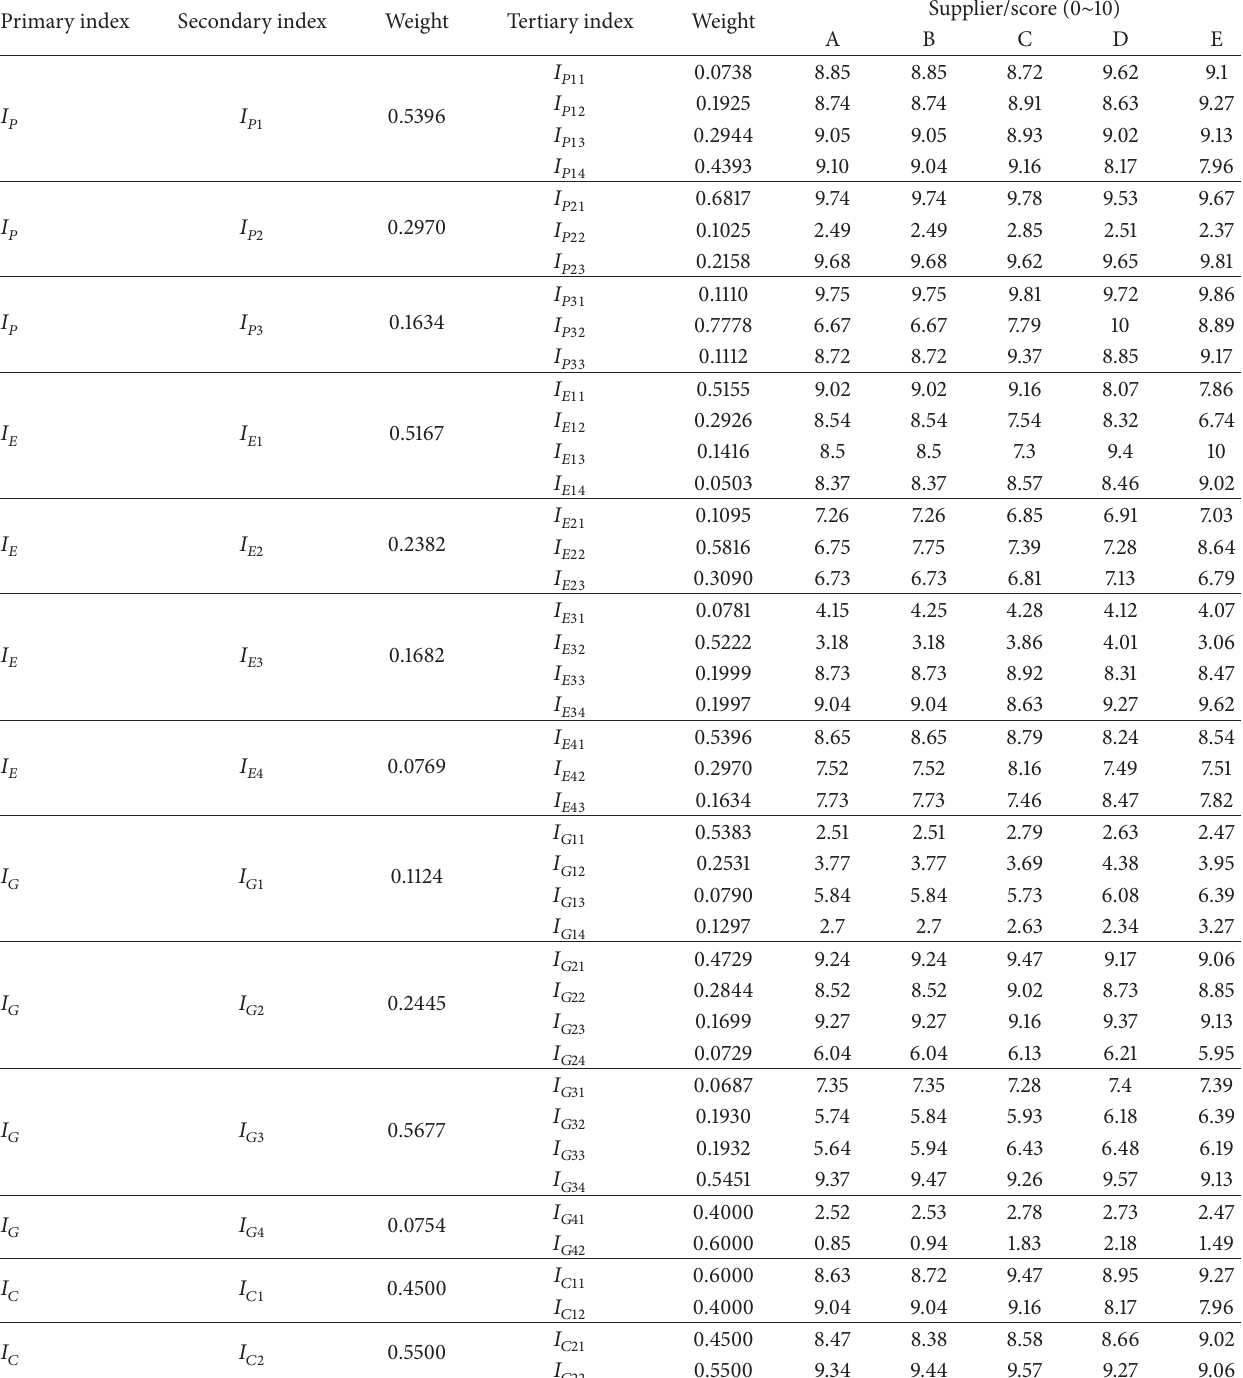
Table 11: Green building parts supplier selection index system and standard